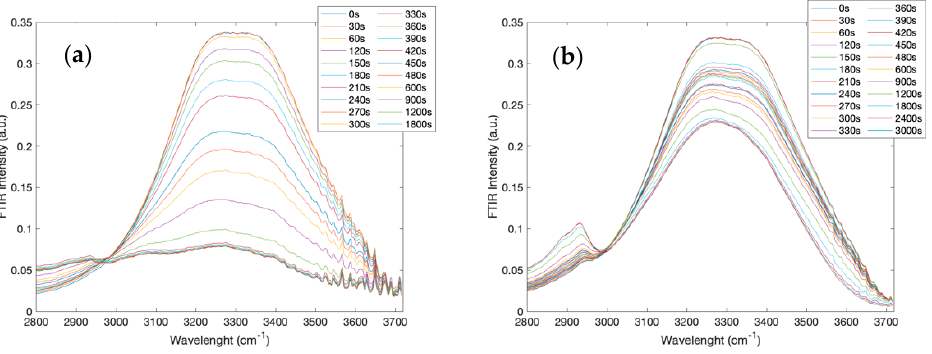
Figure 4. Infrared spectra at different times in the 2800–3700 cm − 1 spectral range, corresponding to the intramolecular OH-stretching region, for the creatine aqueous solution ( a ) and for the creatine aqueous solution in the presence of trehalose ( b ).